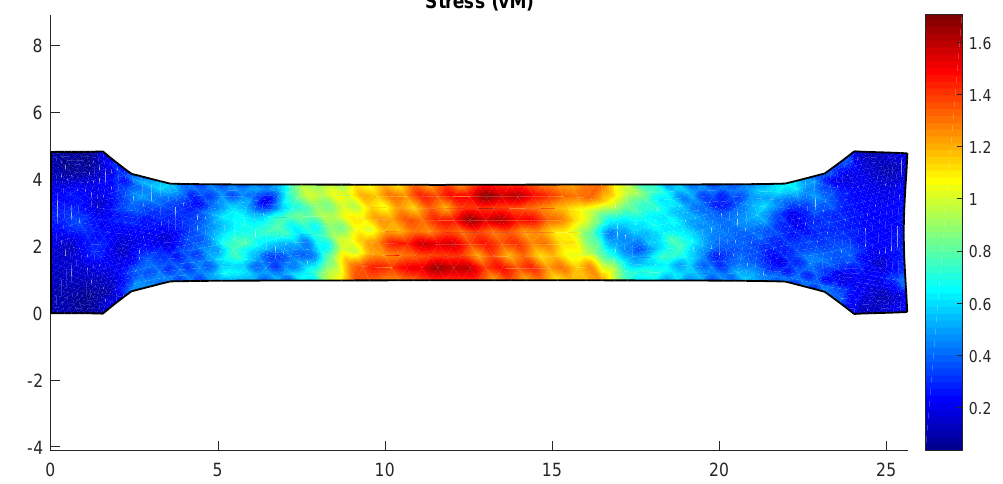
Figure 7. The von Mises stress norm at final time over the deformed